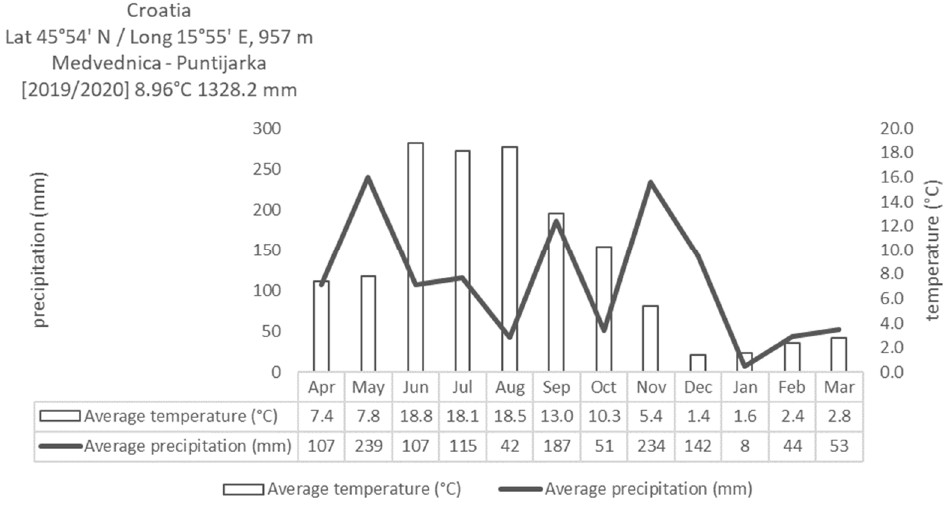
Figure 1. Meteorological data of precipitation and average daily temperature during the growing season of Miscanthus.